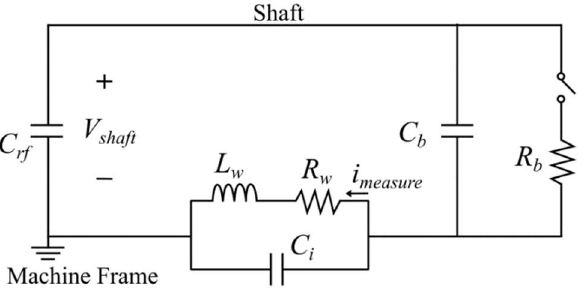
Figure 7. Modified induction motor bearing discharge equivalent circuit model.